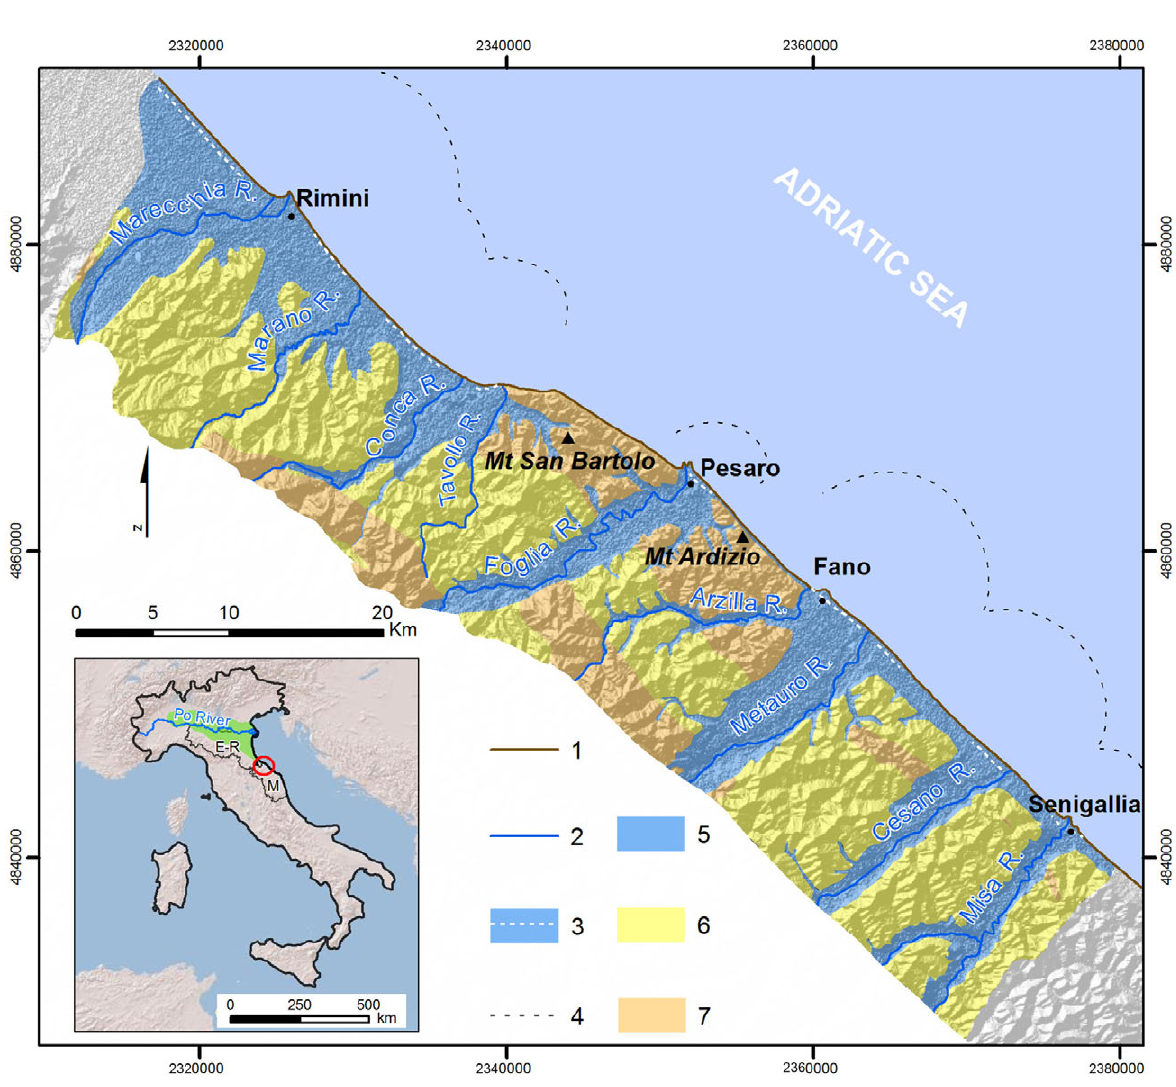
Fig. 1. Location map and geological sketch of the Southern Emilia Romagna-Northern Marche coastal area. Main frame: 1 – coastline; 2 – river; 3 – Holocene wave-cut scarp; 4 – early-Holocene fan assumed extension; 5 – Pleistocene-Holocene fluvial and coastal deposit; 6 – Plio-Pleistocene pelitic and arenitic marine deposit; 7 – Miocene marly-calcareous, evaporitic and terrigenous unit. Lower-left frame: E–R – Emilia Romagna region; M – Marche region; in green, Po-Plain